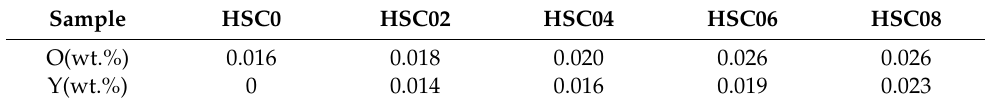
Table 4. O and Y element distribution of the coating samples.